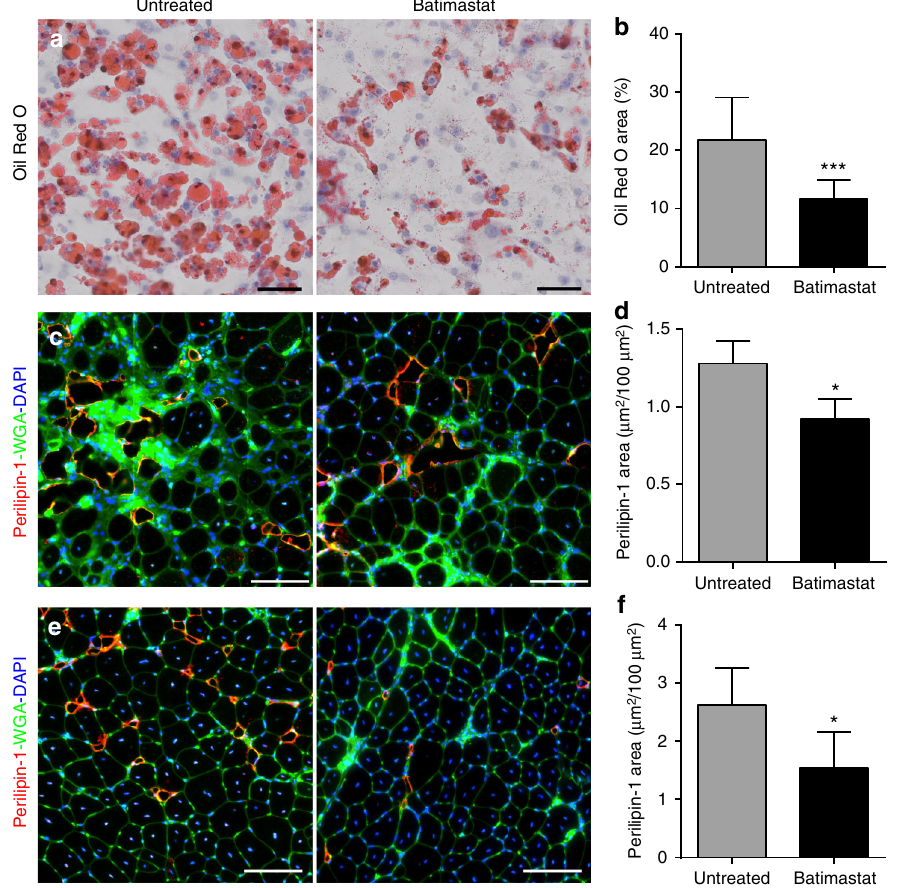
Fig. 7 Batimastat blocks FAP adipogenesis and reduces adipogenic loss of dysferlinopathic muscle. a Oil Red O staining and b quanti fi cation (normalized to 20,000 FAPs) of spontaneous adipogenesis from 40,000 FAPs each, isolated from 12Mo B6A/J, after 10 days in culture ( n = 3 replicates/group). Cells were treated with 10 µ M batimastat starting day 3 in culture. Scale bar = 50 µ m. c Perilipin-1 staining of 14Mo gastrocnemius muscle sections after 10 weeks of batimastat treatment. Scale bar = 100 µ m. d Quanti fi cation of perilipin-1 stained area in gastrocnemius muscle, n = 3 muscles/group. e Perilipin-1 staining of TA muscles from 14Mo B6A/J mice after 3 successive notexin injuries while being treated (or left untreated) with batimastat. Scale bar = 100 µ m. f Quanti fi cation of injury-triggered lipid formation in notexin injured TA muscles corresponding to panel ( e ), n = 6 muscles/group. All quanti fi cations shown are mean ± SD, and statistical comparisons were performed via two-tailed t -test, * p < 0.05, *** p <